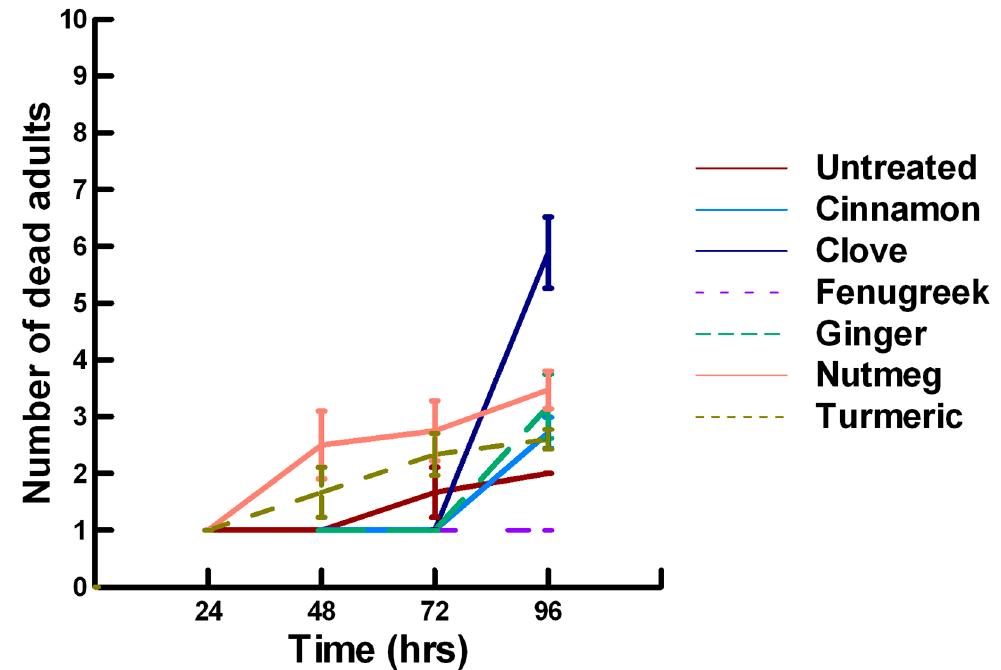
Figure 10. Acute contact toxicity with a low concentration of plant powders from the families Lauraceae (cinnamon), Myrtaceae (clove), Fabaceae (Fenugreek), Myristicaceae (nutmeg) and Zingiberaceae (ginger, turmeric) adherent to male adult Megachile rotundata (ALBs). Means and standard error shown.